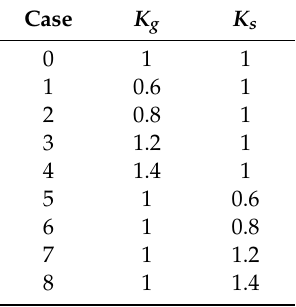
Figure 8. Illustration of the studied region: ( a ) the area of grouting pressure; ( b ) the area of supporting pressure. Table 3. Demonstration of the coefficients used in parametric study.